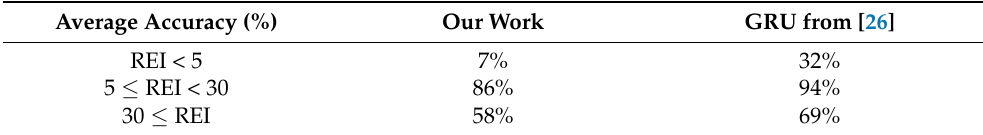
Table 11. REI estimation performance in comparison with GRU from